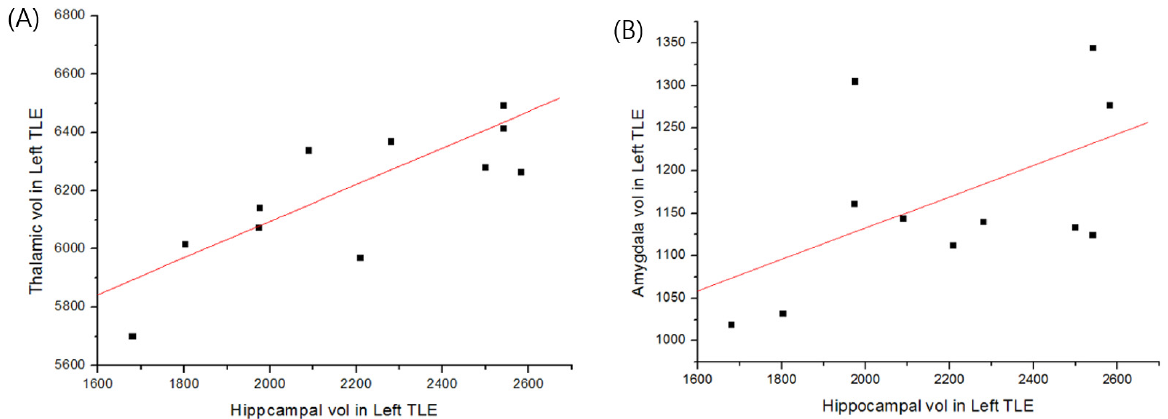
Figure 1. The relationships between the volumes (mm 3 ) of the amygdala, hippocampus, and thalamus in left temporal lobe epilepsy with hippocampal sclerosis (left TLE with HS). ( A ) The volume of the left hippocampus was positively correlated with that of the left thalamus in patients with left TLE ( p = 0.00688). ( B ) No correlation was observed between the left hippocampus and left amygdala ( p = 0.06832), entorhinal cortex, or fornix (not shown) in the patients with left TLE.